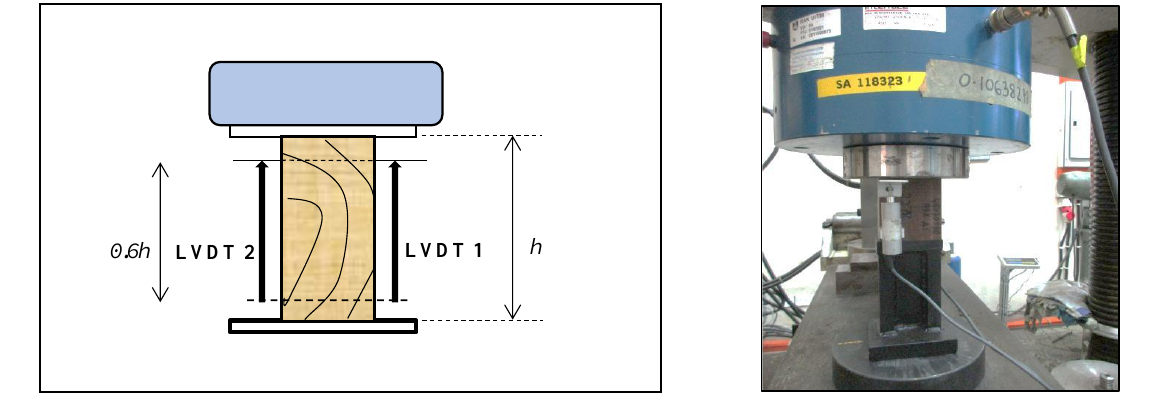
Figure 3. Test setup for determining compressive strength properties perpendicular to the grain.